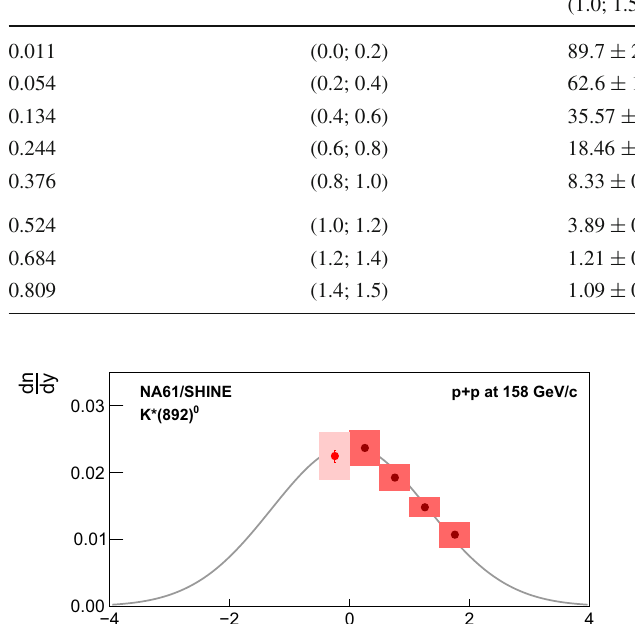
Fig. 12 The p T -integrated and extrapolated rapidity distribution. The fitted Gaussian function (solid line) is given by Eq. (17); the first point (with y < 0) was not included in the fit (see the text for details). The numerical data are listed in Table 5